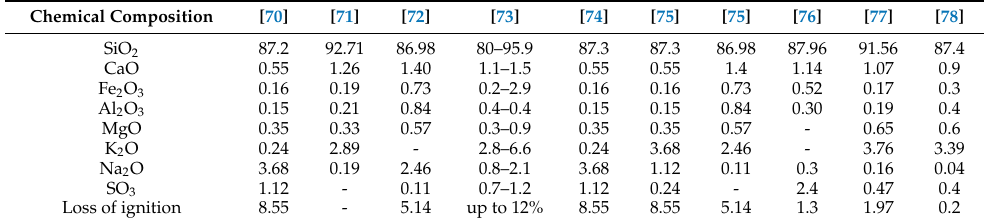
Table 4. The oxide content of the RHA by various researchers.